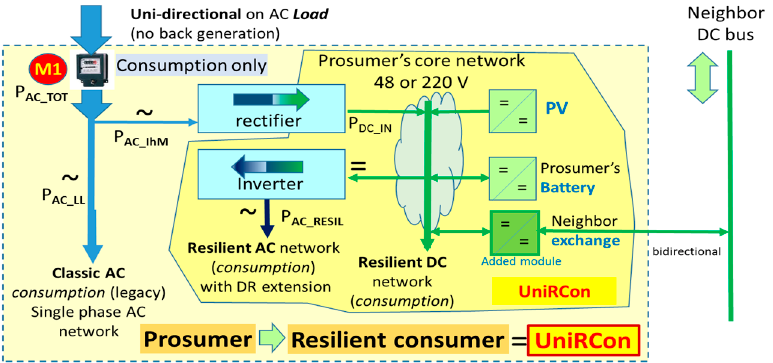
Figure 9. Extension of the resilient architecture of the prosumer.